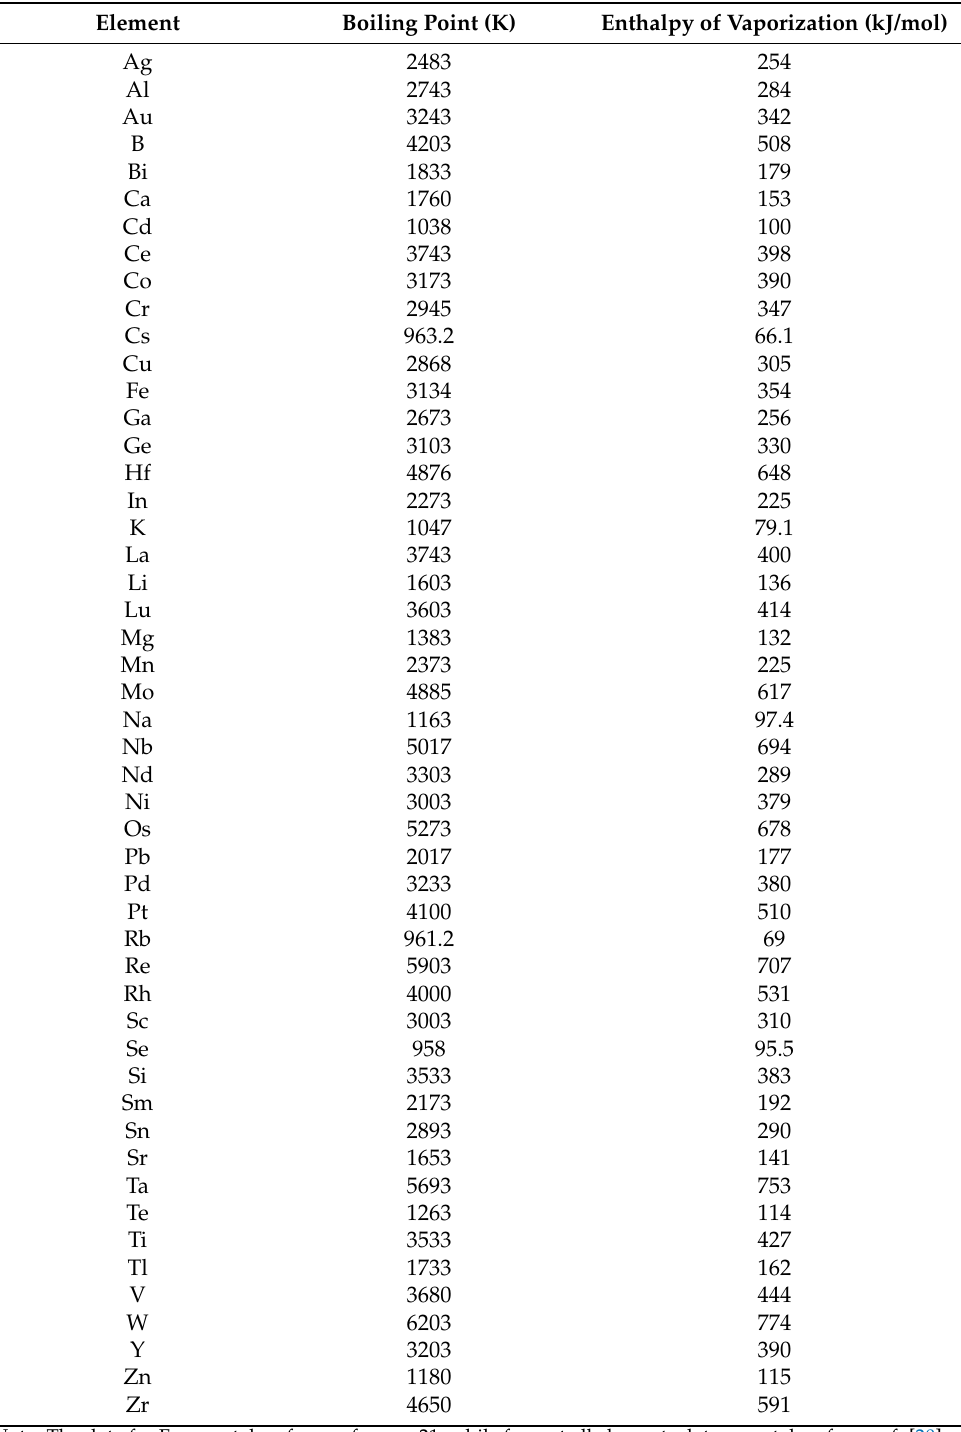
Table 1. Boiling points and enthalpy of vaporization of elements used in the Clausius Clapeyron equation [20,21]. Element Boiling Point (K) Enthalpy of Vaporization